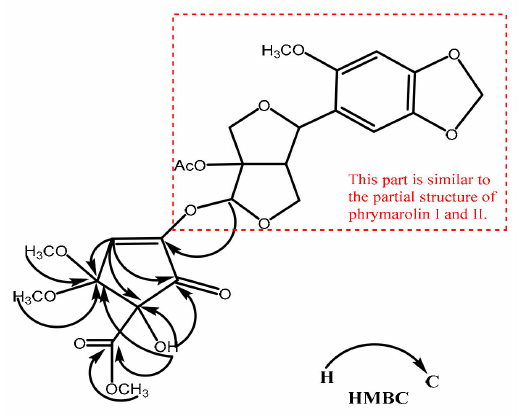
Figure 2. Key HMBC long-range correlations between C and H atoms of compound T4 .